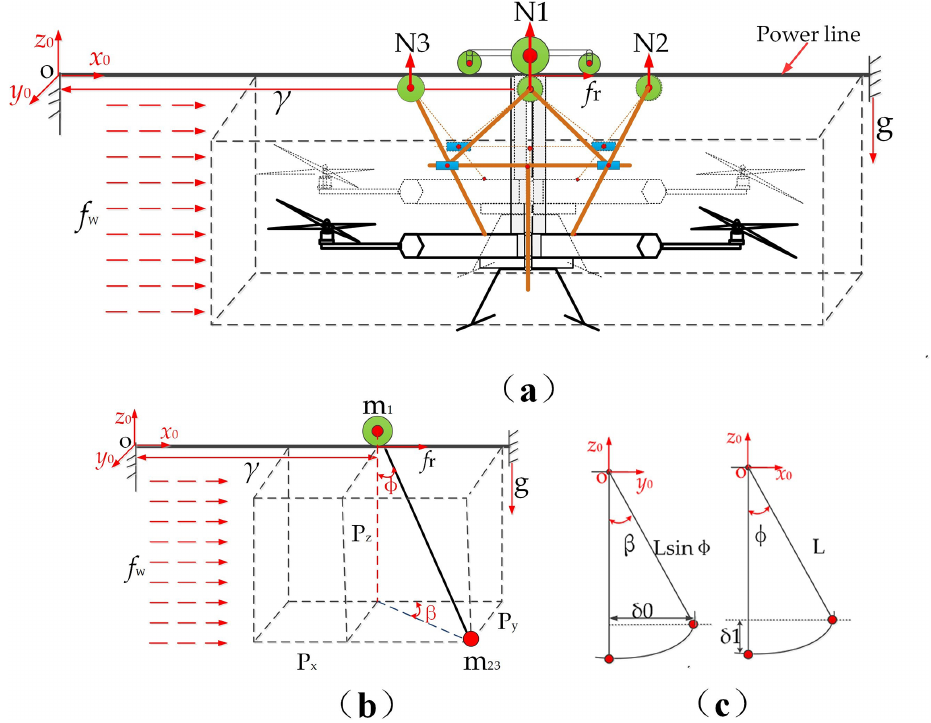
Figure 13. (a) Potential wind disturbance on the FPLIR–line coupled system. (b) The schematics of the FPLIR–line model under the influence of wind. (c) The schematics of the FPLIR showing its horizontal swing displacement on the y 0 axis ( δ 0 ); the schematics of the robot showing its vertical swing displacement on the z 0 axis ( δ 1